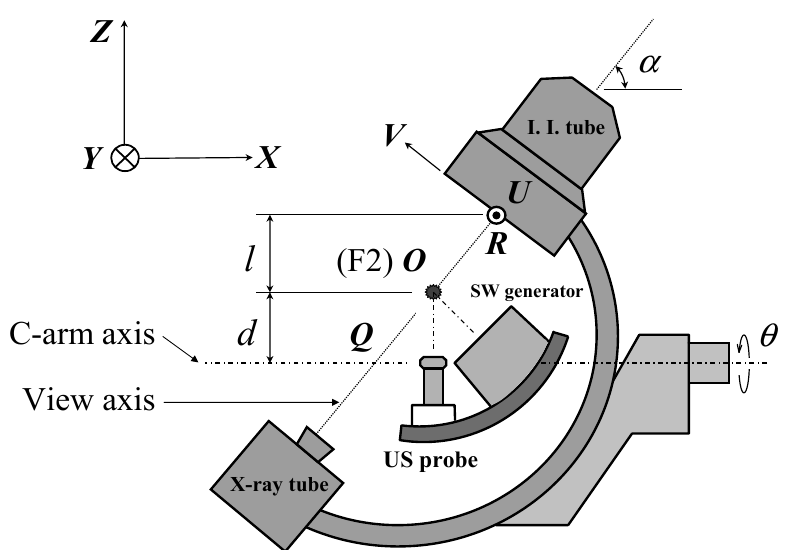
Figure 2. The geometry of the dual stone location apparatus.